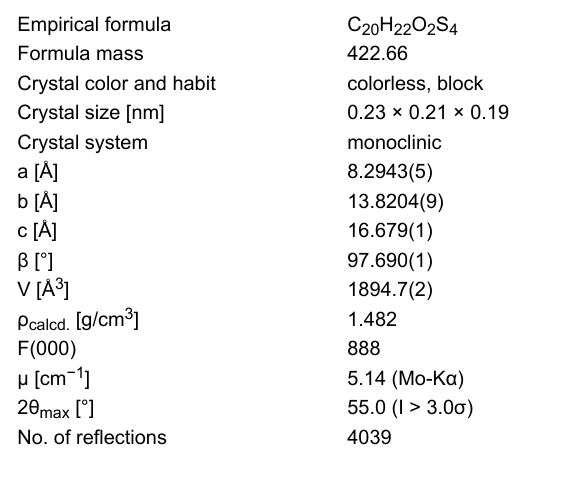
Table 1: Summary of crystallographic data and refinement